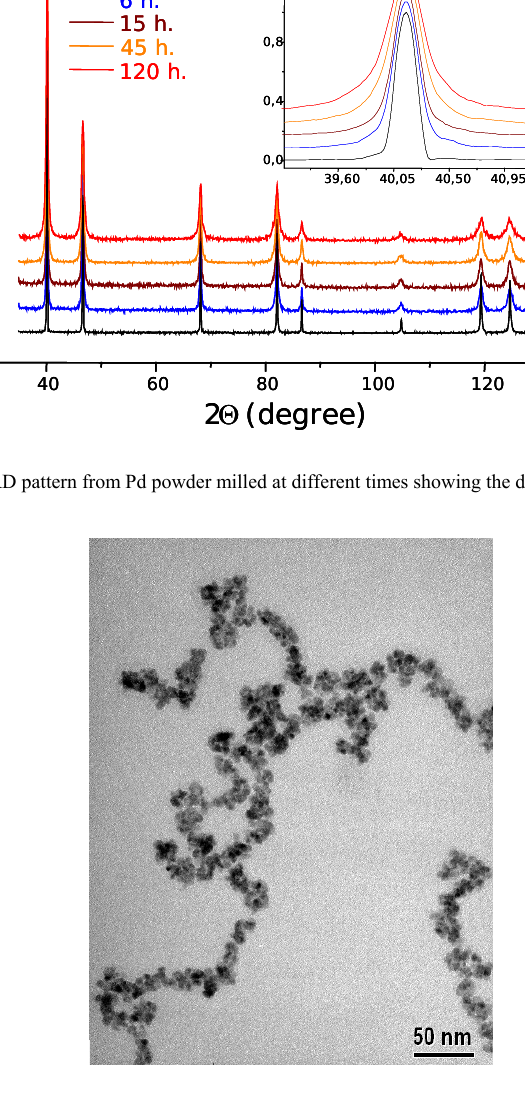
FIGURE 8 . TEM micrograph corresponding to Pd powder milled for 6 h (courtesy of B. Sampedro).